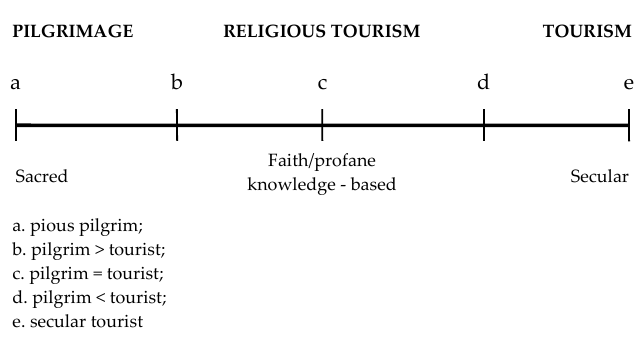
Figure 1. The Pilgrim-Tourist Path. ( Source: Smith (1992a)).